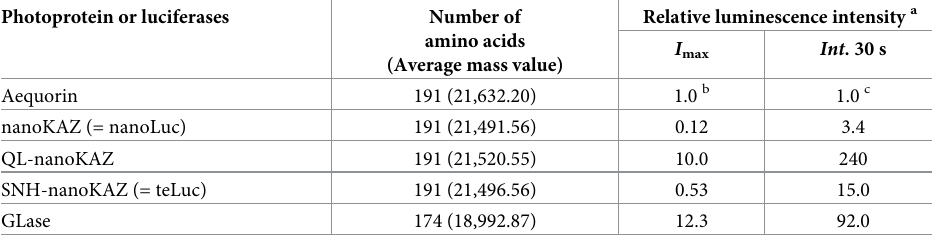
Fig 4. Luminescence properties of QL-nanoKAZ. A. Luminescence kinetics of QL-nanoKAZ with CTZ and its analogs as substrates. B. Normalized luminescence spectra of QL-nanoKAZ with CTZ and its analogs, based on the luminescence intensity of QL-nanoKAZ with CTZ. C. Linearity of luminescence intensity ( I max ) of QL-nanoKAZ with CTZ, in comparison with nanoKAZ, SNH-nanoKAZ, GLase, and aequorin at the protein concentrations of 0.3 pg to 3 ng ( n = 6). Solid and dashed lines represent blank + 3 SD for aequorin and the CTZ-utilizing luciferases, respectively.